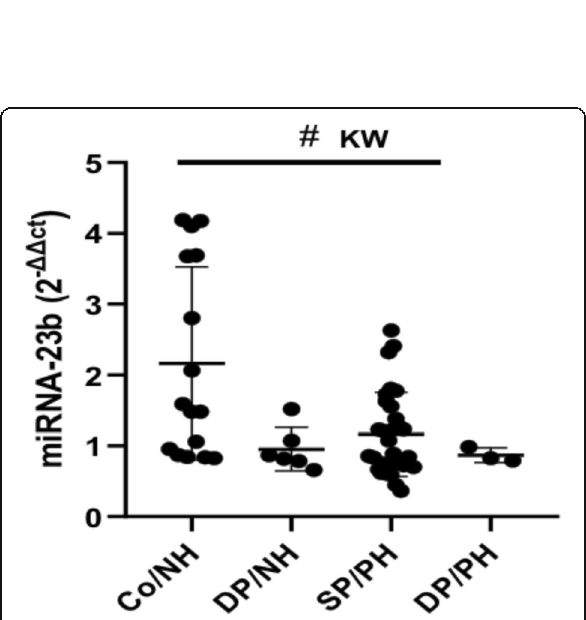
Fig. 2 Changes in the miR-23b expression levels in late onset sepsis. Scatter plot values represent the miR-23b level for LOS in at-term newborns, measured by (2 - ΔΔ CT ). The line inside the boxes corresponds to the median values. Co/NH ( n =6), DP/NH ( n =2), SP/PH ( n =12), DP/PH ( n =1). Co/NH: negative haemoculture, DP/NH: negative haemoculture in the dead newborns, DP/PH: positive haemoculture in the newborns who died, SP/PH: positive haemoculture in the newborns who survived, KW: Kruskal-Wallis. The sharp indicate significant differences highlighted between all groups using the Kruskal-Wallis test: # p